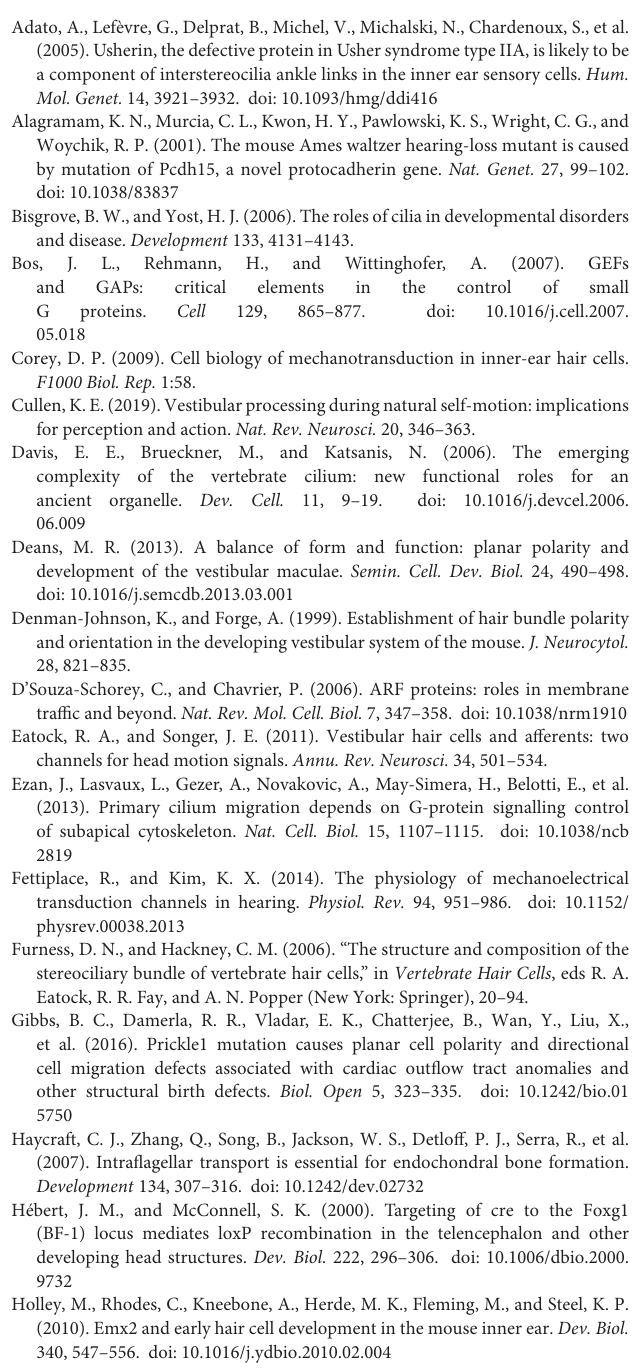
Supplementary Figure 3 | (A,A1) Normal appearance of anterior cristae in wild-type controls. The utricle is labeled with an anti- β -spectrin, the hair cell basal body is labeled with anti- γ -tubulin (blue), while stereocilia bundles are labeled with phalloidin (green). In the anterior and superior cristae of the mouse vestibular system, the well-organized planar cell coordination can be observed. (B,B1) In Rab11a mutants, the alignment of neighboring hair cells was not disrupted in P2 hair cells of the anterior cristae. (C,C1) Tissue planar cell polarity could be seen in